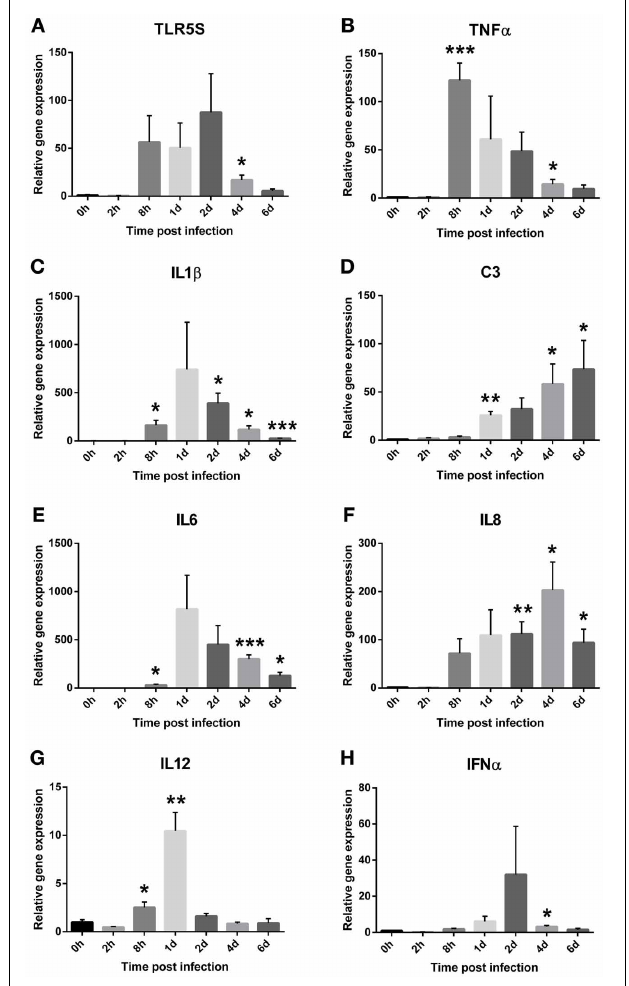
FIGURE 3 | Relative expression levels of the salmon immune parameters (A) TLR5S, (B) TNF α , (C) IL1 β , (D) IL6, (E) IL8, (F) C3, (G) IL12, and (H) IFN α in the spleen during an experimental V. salmonicida i.p.-infection. Each time point represents the average expression level of four fish and is reported as fold change ± standard error of the mean (s.e.m.) compared to the average expression levels of four control